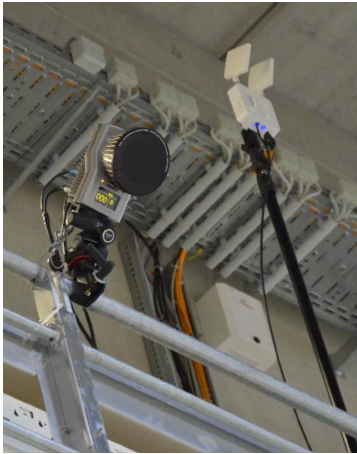
Figure 1. Balcony-mounted Qualysis camera (left) and Kinexon antenna (right).